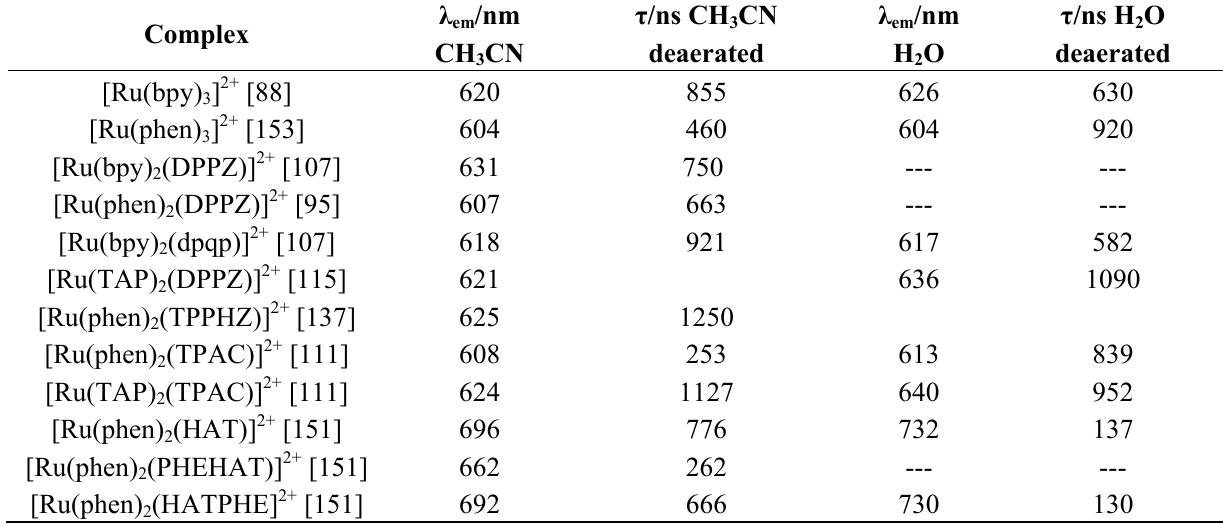
Table 4. Emission properties of representative ruthenium II mononuclear complexes.